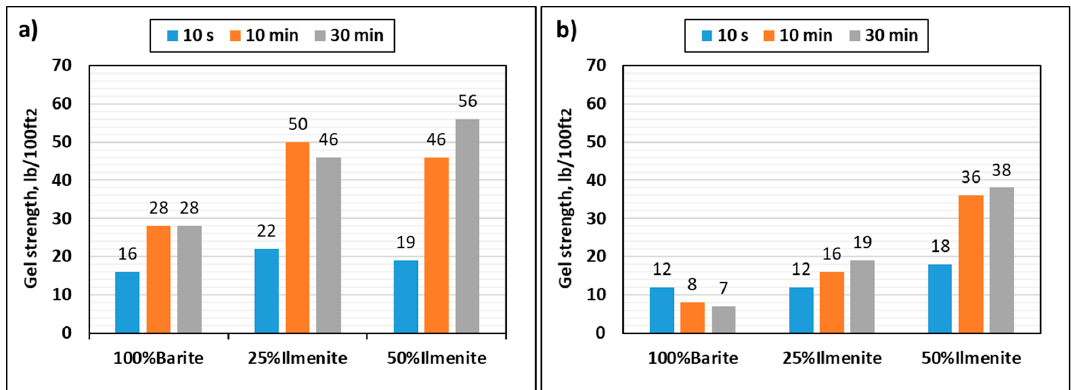
ff ect of ilmenite on gel strength at ( a ) 120 ◦ F, and ( b ) 250 ◦ Figure 9. Effect of ilmenite on gel strength at (a) 120 °F, and (b) 250 °F. Figure 9. E Figure 9. Effect of ilmenite on gel strength at (a) 120 °F, and (b) 250 °F.